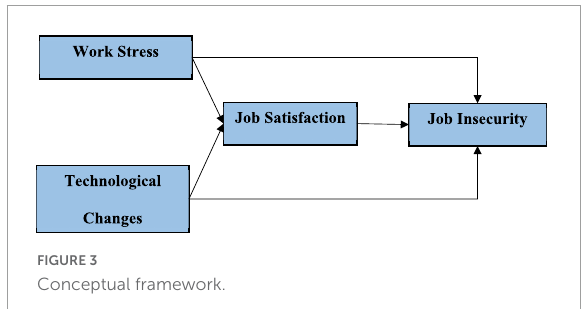
FIGURE3 Conceptual